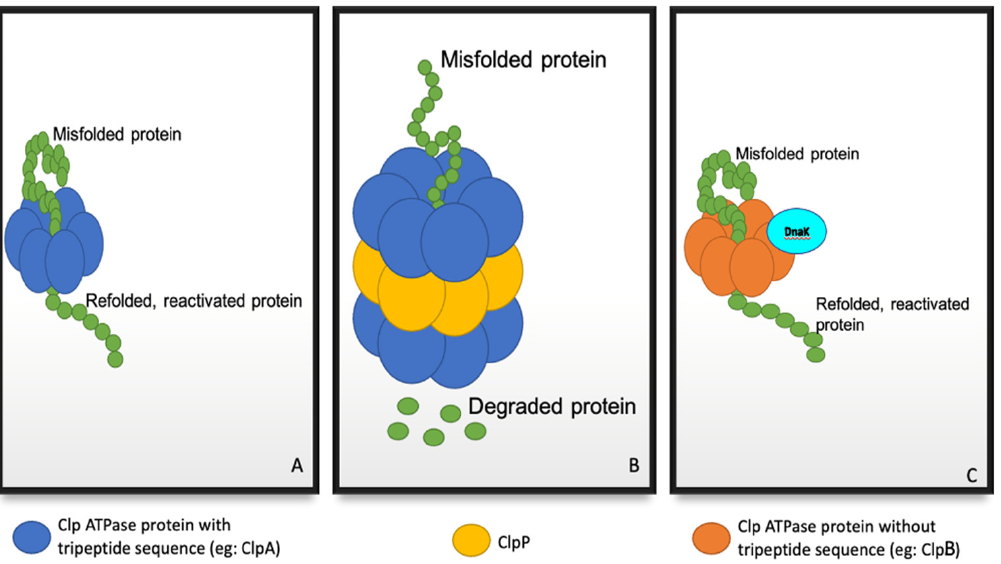
Figure 1. The function of the regulatory and catalytic components of Clp proteins. ( A ) The ATPase regulatory subunit (e.g.: ClpA) alone, functions to unfold and reactivate misfolded proteins. ( B ) The ATPase regulatory and catalytic (ClpP) subunits function as a complex to degrade misfolded proteins which cannot be reactivated. ( C ) Some ATPase regulatory subunits (e.g.: ClpB) do not interact with ClpP [10,11].